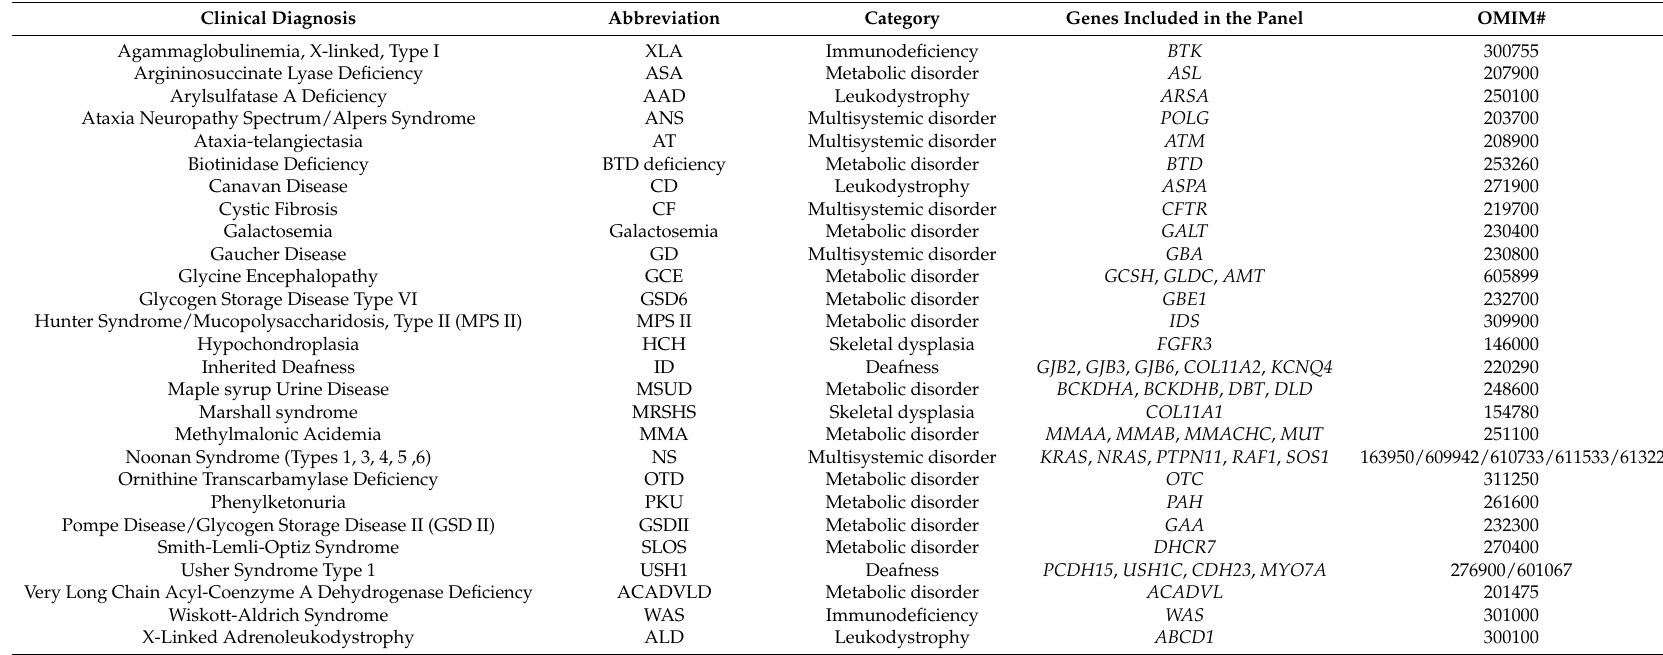
Table 1. List of inherited conditions tested in this